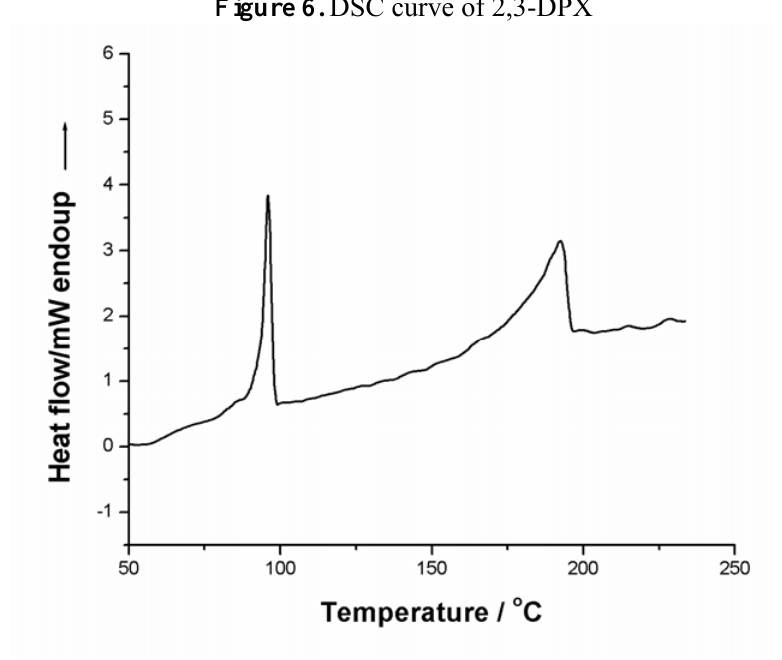
Figure 6. DSC curve of 2,3-DPX